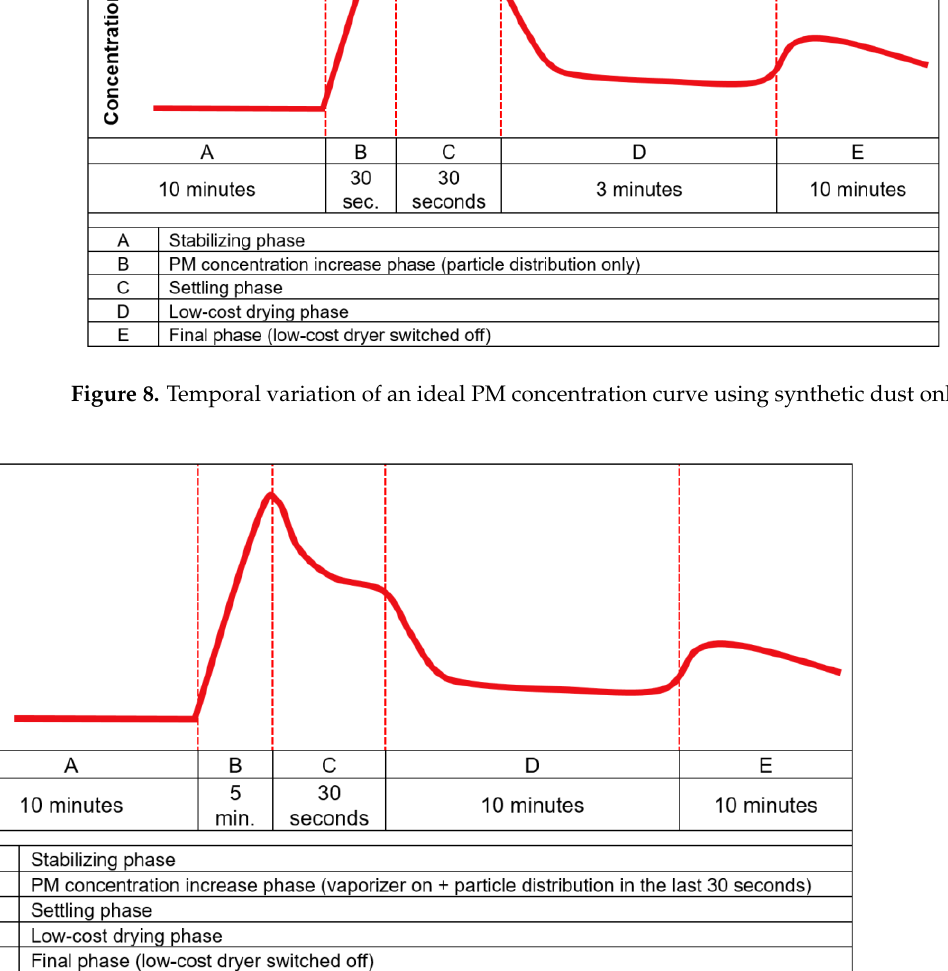
Figure 9. Temporal variation of an ideal PM concentration curve using synthetic dust and vaporizer.